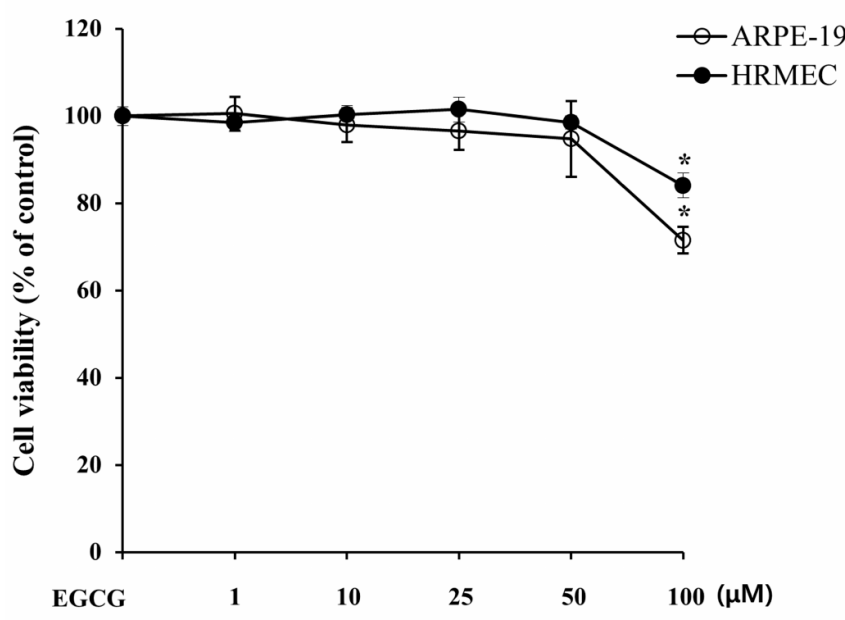
Figure 2. Cytotoxicity of EGCG to ARPE-19 and HRMEC. ARPE-19 cells and HRMEC were treated with or without EGCG for 24 h, and cell viability was assessed by 3-(4,5-dimethylthiazol-2-yl)-2,5-diphenyltetrazolium bromide (MTT) assay. The results are expressed as percentage of control and are presented by mean ± SD (n = 9). * , p < 0.01 vs. EGCG